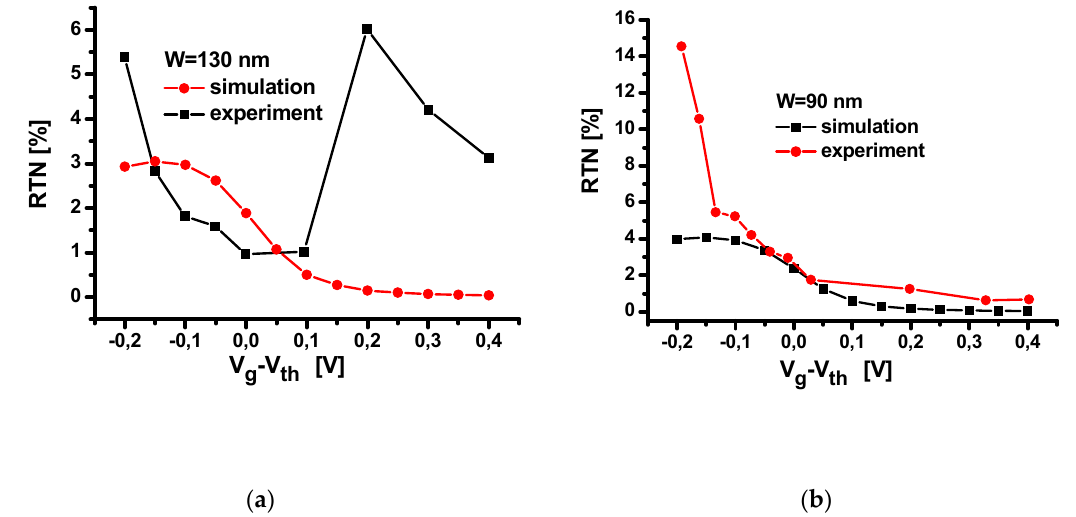
Figure 4. RTN amplitude dependence on the gate overload for the planar MOSFET with gate widths 130 ( a ) and 90 ( b ) nm.